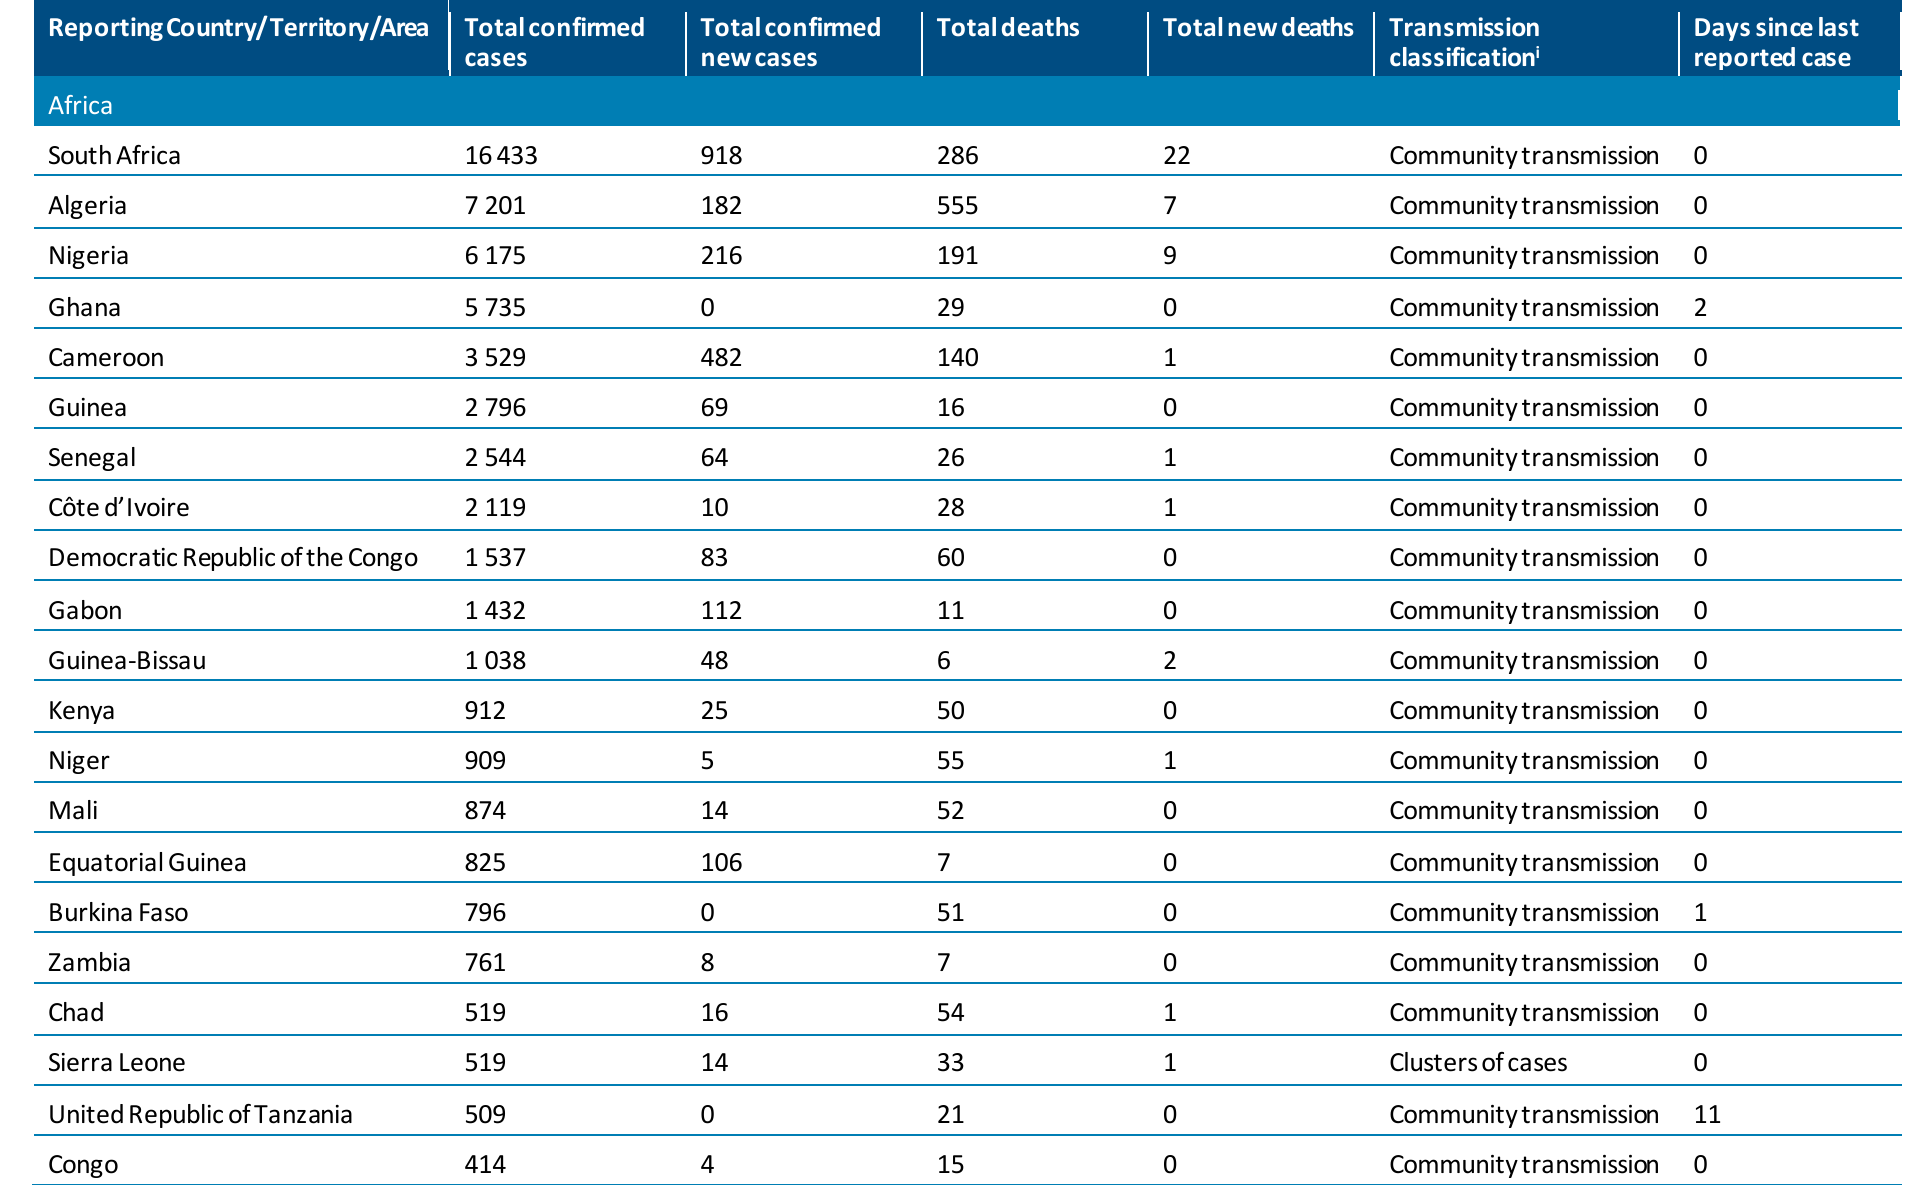
Table 1. Countries, territories or areas with reported laboratory-confirmed COVID-19 cases and deaths, by WHO region. Data as of 10 AM CEST, 19 May 2020** Reporting Country/